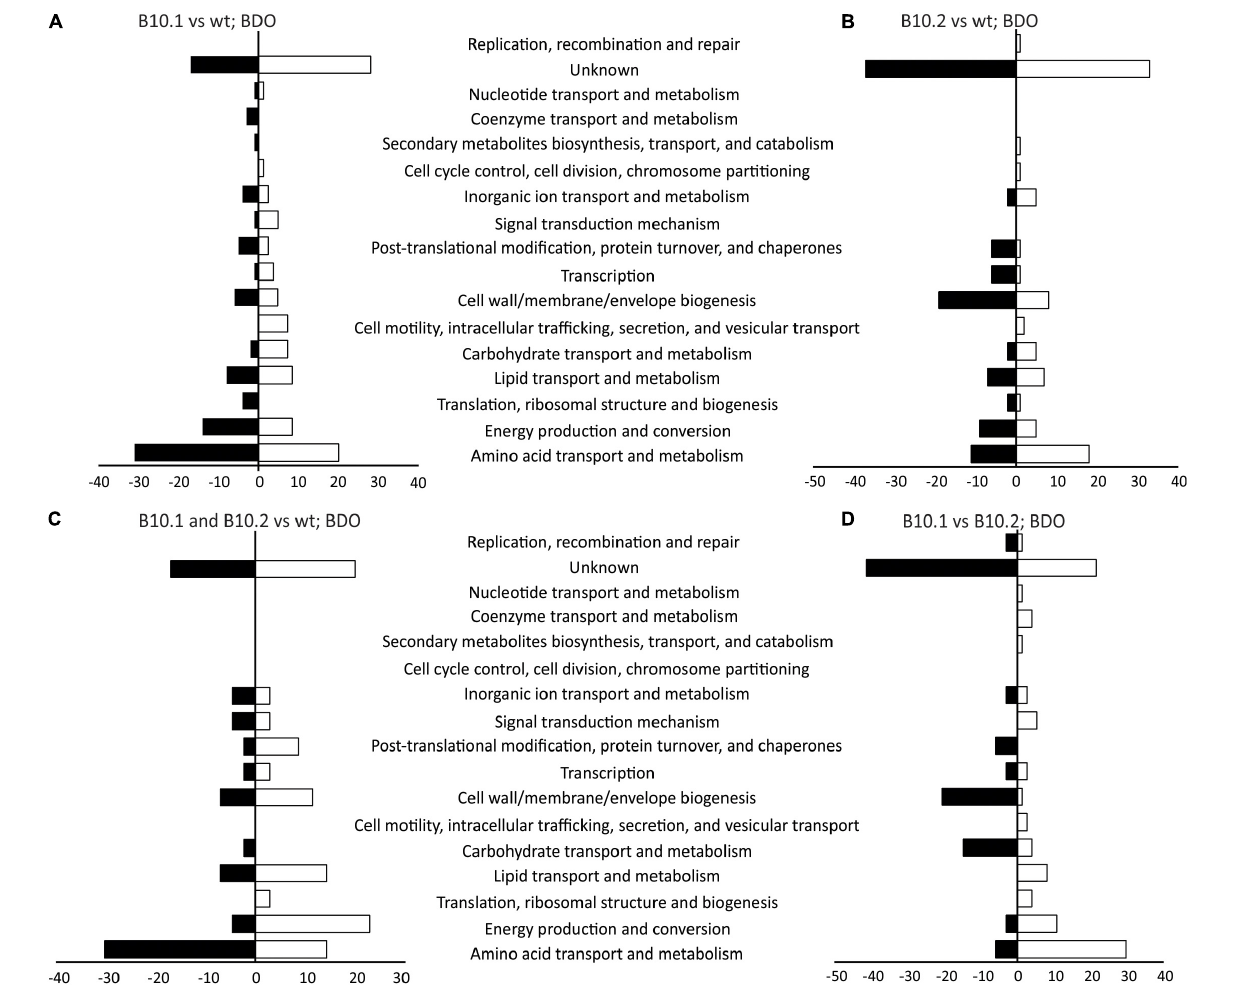
FIGURE 2 | Proteins with significantly different levels of expression between the evolved strain B10.1 and wildtype P. putida KT2440 (A) , the evolved strain B10.2 and wildtype P. putida KT2440 (B) , the proteins showing the same trend of upregulation or downregulation in both evolved strains compared to the wild type (C) , and the proteins with different levels of expression in B10.1 and B10.2 (D) when grown with 1,4-butanediol (BDO) as a carbon and energy substrate. The number of proteins showing ≥ 2-fold change ( T -test, FDR 0.01) in expression are given as clusters of orthologous groups